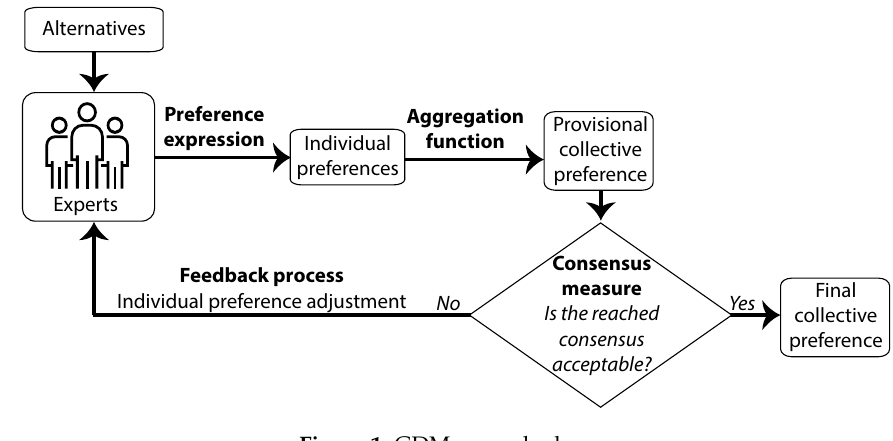
Figure 1. GDM general